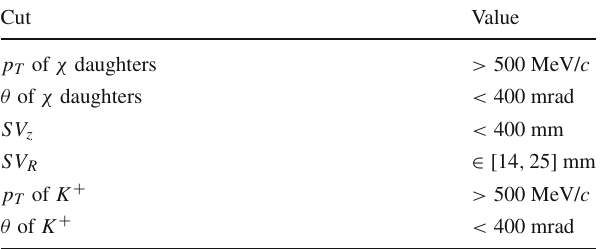
Table 6 List of analysis cuts for the LHCb reach estimate for a hadron- icallydecaying,long-livedparticle( χ ). SV z and SV R respectivelystand for the longitudinal and transverse position of the secondary vertex, and θ is the angle of the track with respect to the beam